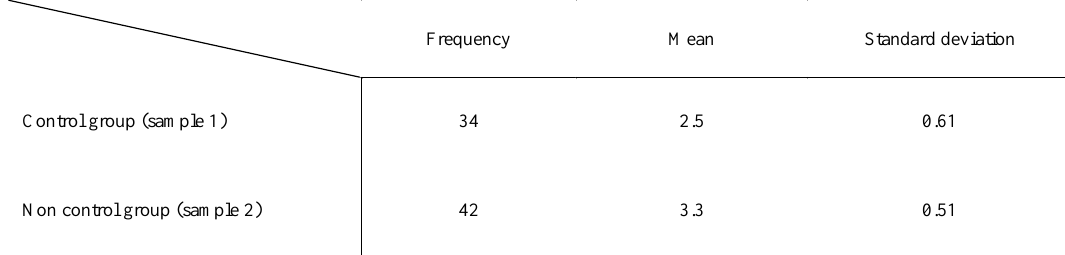
Table 3: Group statistics for commitment